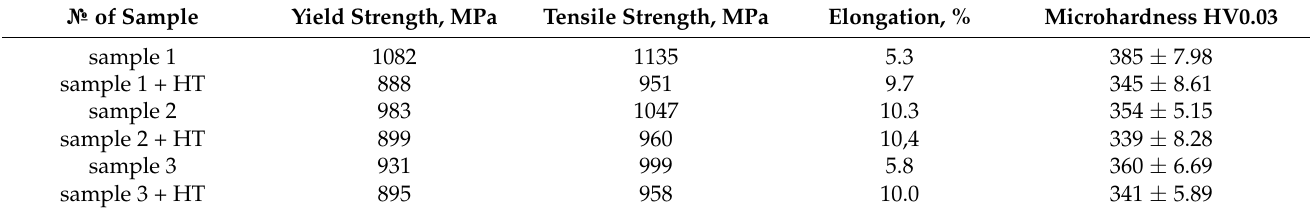
Figure 7. Microstructure of deposited Ti-6Al-4V with different initial structure ( a ) sample 1 ( α + α ’), ( b ) sample 2( α + β ), and ( c ) sample 3( α + α ’ + β ). Table 4. Mechanical properties of samples deposited with different thermal cycles before and after